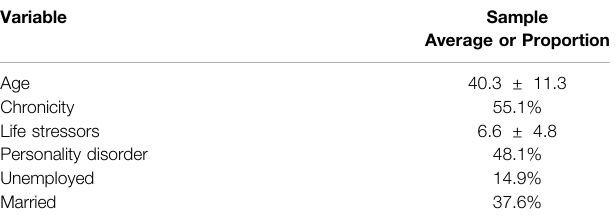
TABLE 3 | Baseline characteristics of the subjects in the clinical trial example for the moderating variables employed in our personalization model. These statistics differ slightly from those found in the tableof DeRubeis et al. (2005, page 412) as here they are tabulated for subjects only after dropout ( n (cid:2) 154).